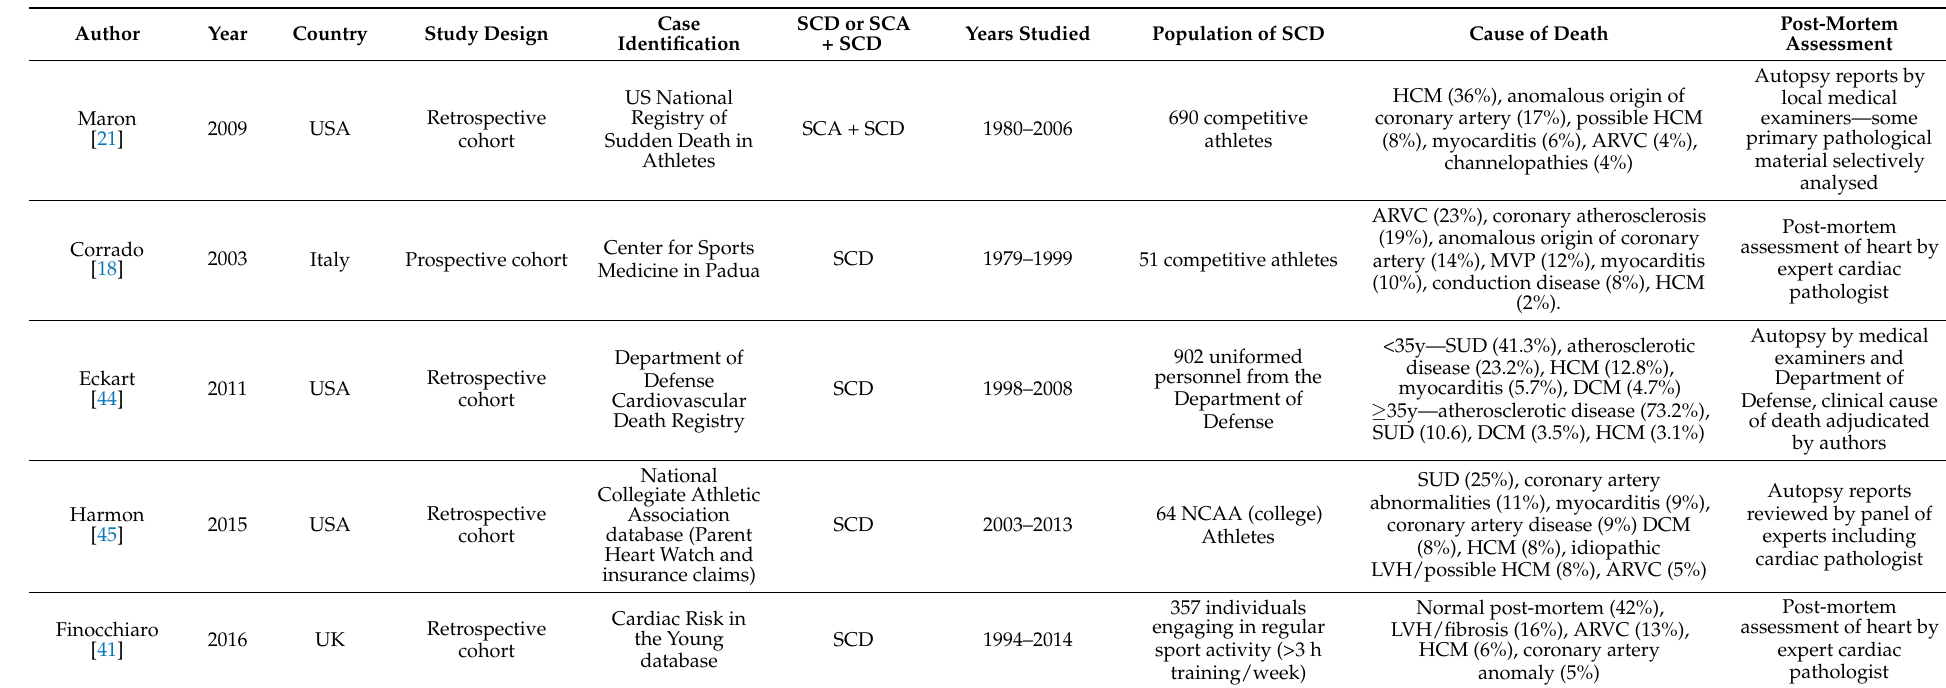
Table 2. Causes of death in